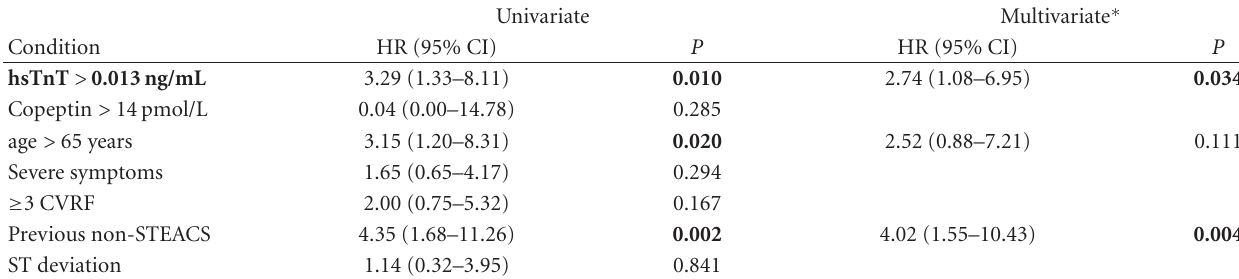
Table 4: Cox regression analysis at 12-month followup.